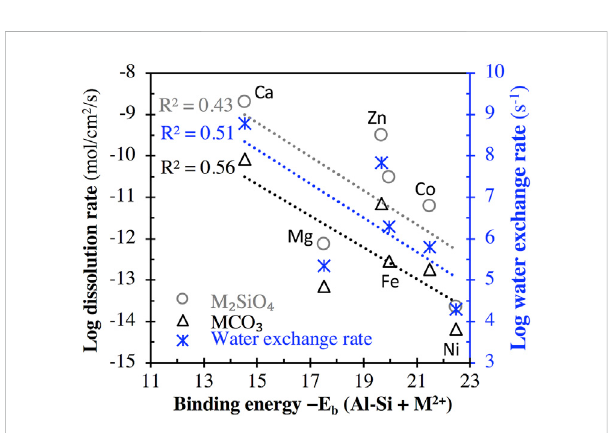
FIGURE 6 Comparison of the binding energy between the aluminosilicate dimer and divalent cation M 2+ (M 2+ = Ca 2+ , Mg 2+ , Zn 2+ , Fe 2+ , Co 2+ , and Ni 2+ ) with (i) the log dissolution rate (in mol/cm 2 /s) of M 2 SiO 4 minerals atpH=2 ° Cand25 ° CandMCO 3 mineralsat5 < pH < 8 ° Cand25 ° C (left axis), and (ii) the log rate constant for water exchange from the hydration sphere of the dissolved cation to the surrounding solvent (right axis). Rate data of M 2 SiO 4 minerals are from ref. (Casey and Westrich, 1992), while the rate data of MCO 3 minerals and water exchange are from ref. (Pokrovsky and Schott, 2002). R 2 values for linear regression are also